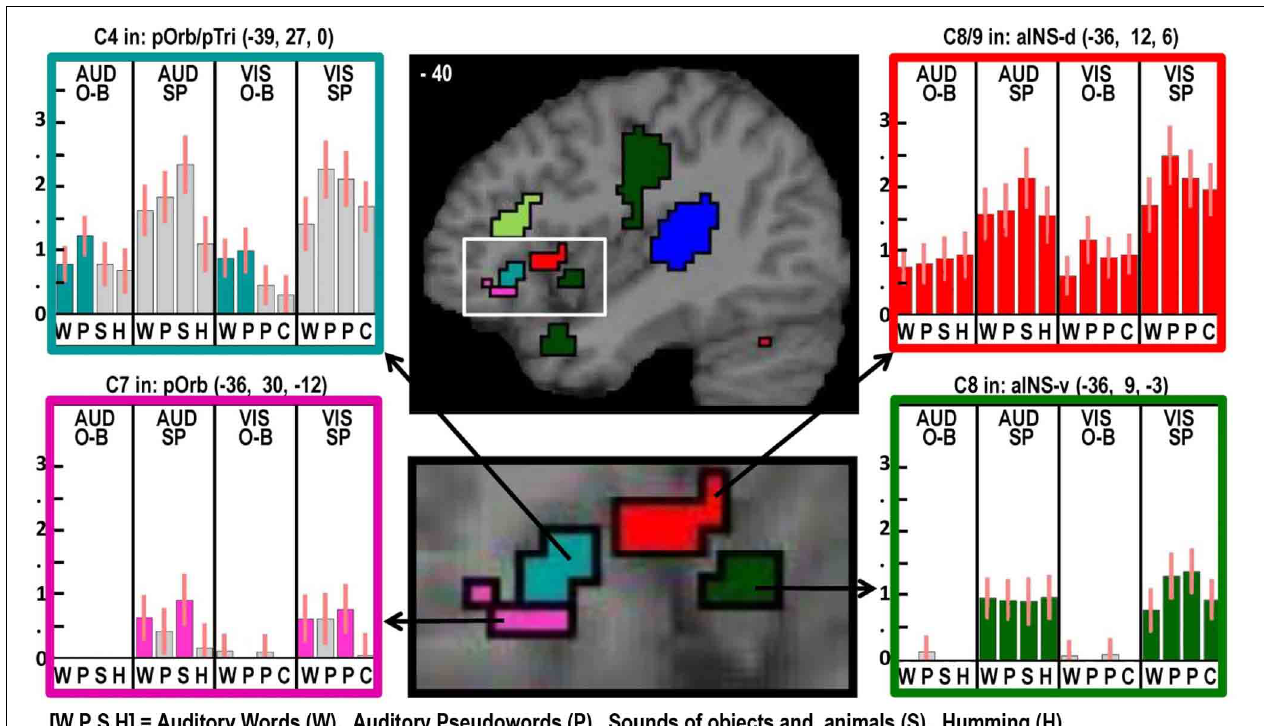
FIGURE 4 | As in Figures 2, 3 but with effects located at x = − 40 in MNI space to highlight multiple effects in the left insula and frontal operculum within the white box (brain image above), which is enlarged (brain image